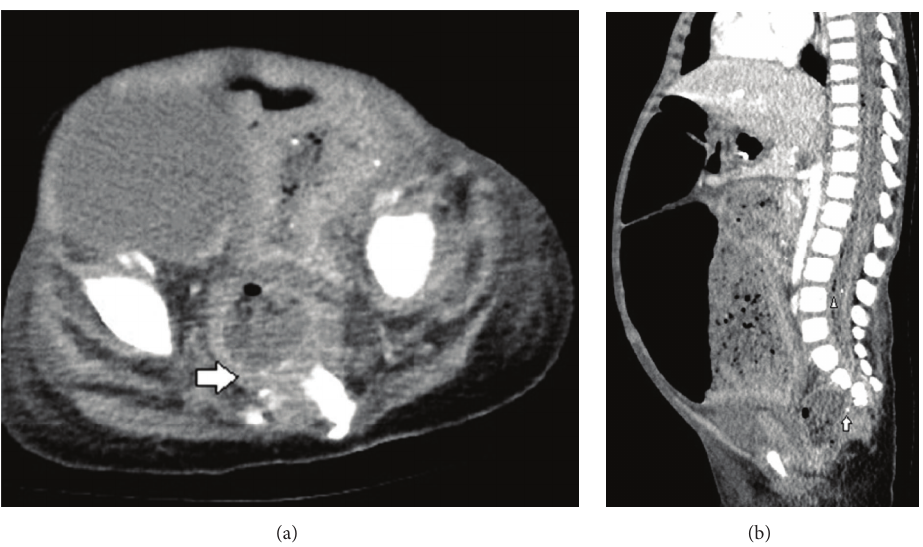
Figure 3: Abdominal CT on day 4 for evaluation of progressive abdominal distention. (a) Axial CT slice through the lower pelvis shows hypoplasia of the sacrum and an indeterminate presacral mass extending into the spinal canal (arrow). The mass contains heterogeneous material and air and the contents have a similar appearance to the fecal material in the bowel. (b) Sagittal abdominal CT reformat again shows the presacral mass in continuity with the sacral canal having a few fecaliths. Notice few fecaliths (arrow) and air (arrowhead) in the spinal canal, suggesting communication with the anal